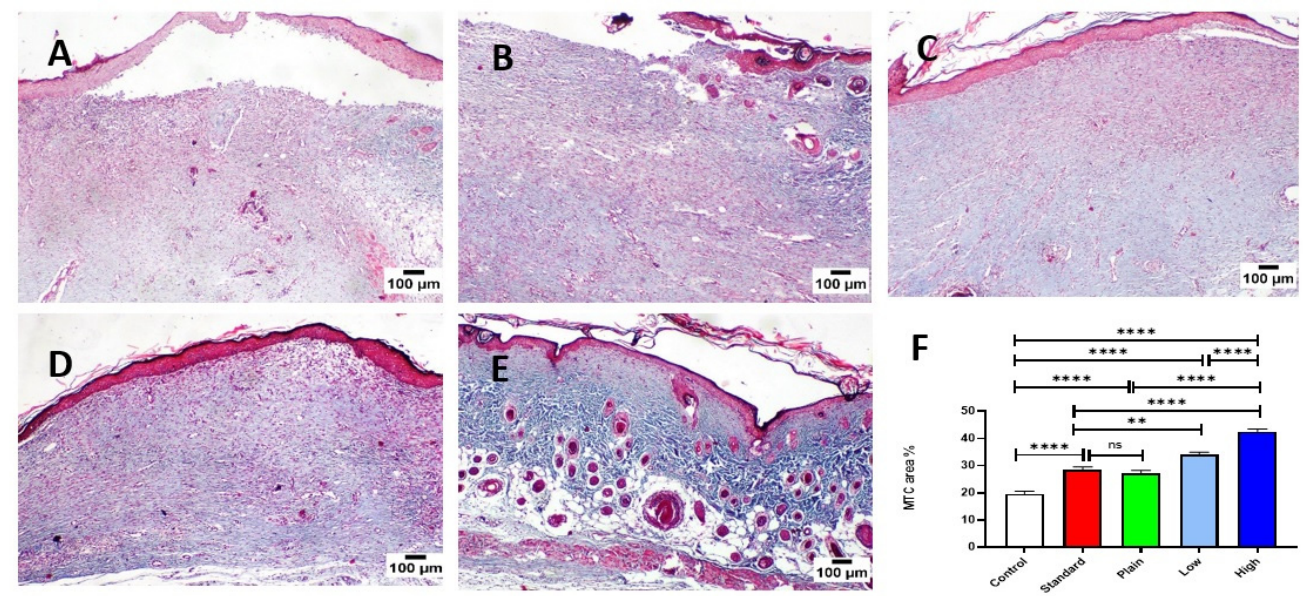
Figure 8. Histopathological examination of the healed tissue. Microscopic images of skin, HE stained ( A ) control group, ( B ) standard gentamicin (0.1% garamycin cream), ( C ) plain, ( D ) low, and ( E ) high. Charts, histopathological evaluation of ( F ) re ‐ epithelization, ( G ) granulation tissue for ‐ mation, ( H ) inflammation, and ( I ) angiogenesis. Data represented as mean ± SE of at least 5 wounds. **** for p < 0.0001, *** for p < 0.001, ** for p < 0.01, * p < 0.05, ns for non ‐ significant.